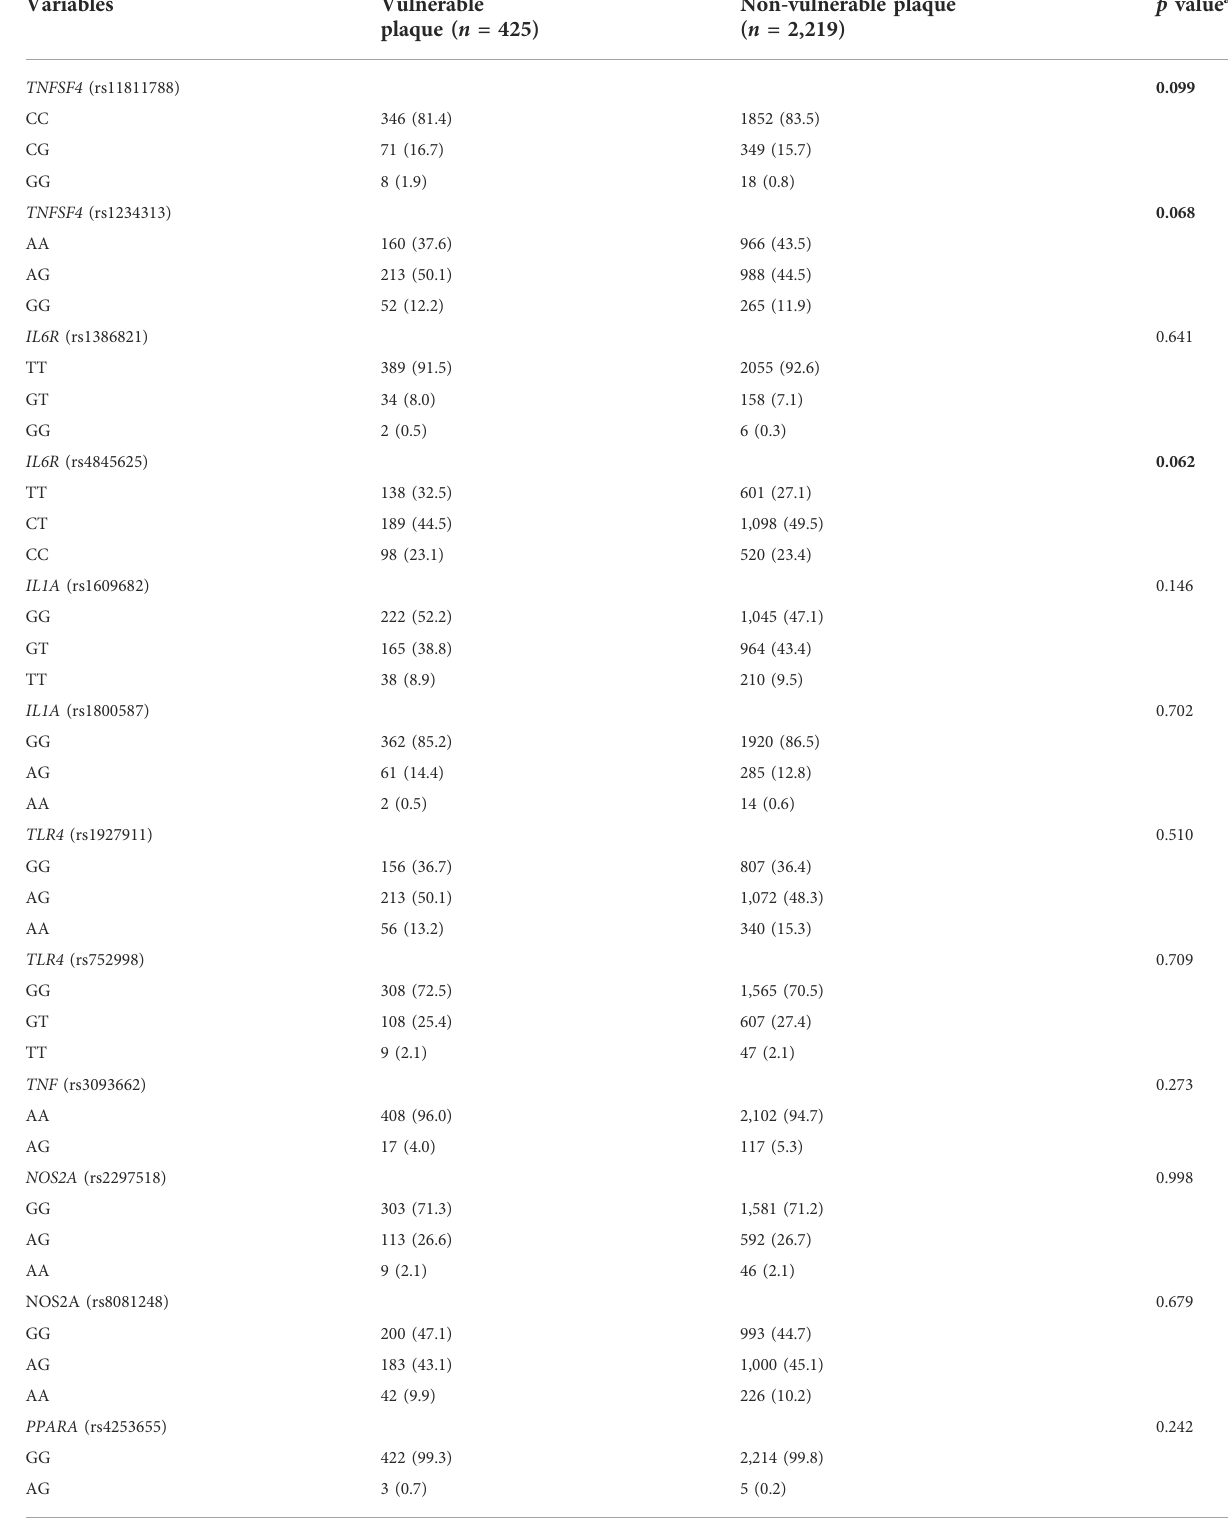
TABLE 2 Genotype distribution between vulnerable plaque group and non-vulnerable plaque